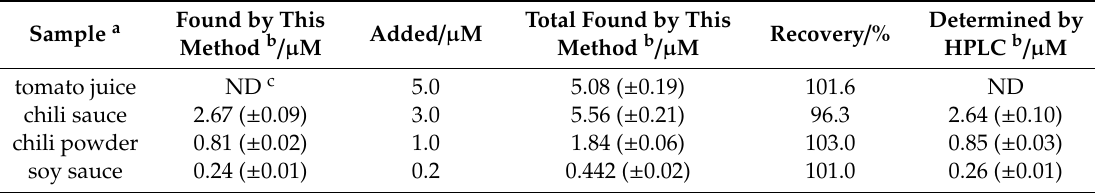
Table 2. Determination of RhB in real food samples ( n =